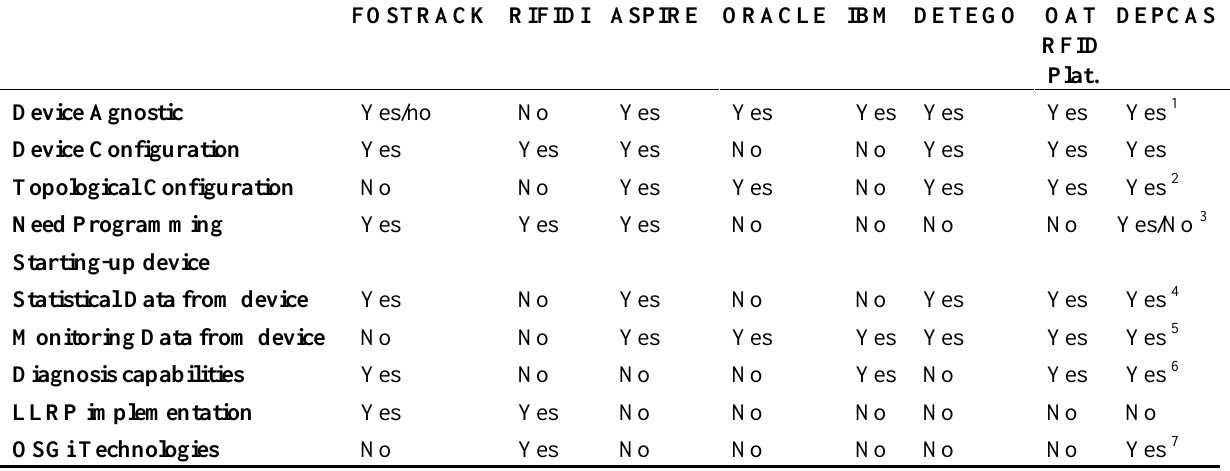
Table 1. DEPCAS MDM support comparison to related work. FOSTRACK RIFIDI ASPIRE ORACLE IBM DETEGO OAT